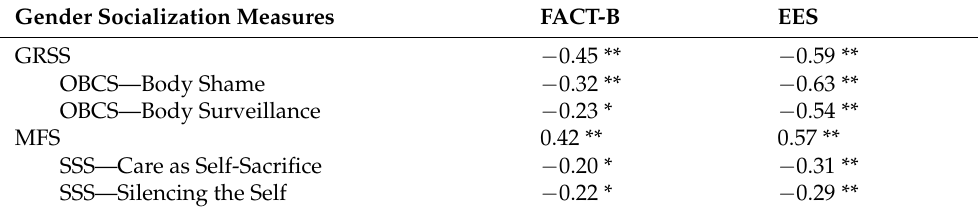
Table 3. Correlations among well-being and gender socialization scores.